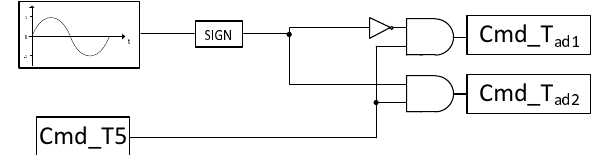
Figure 8. Block diagram of the signal generation for T ad 1 e T ad 2 .